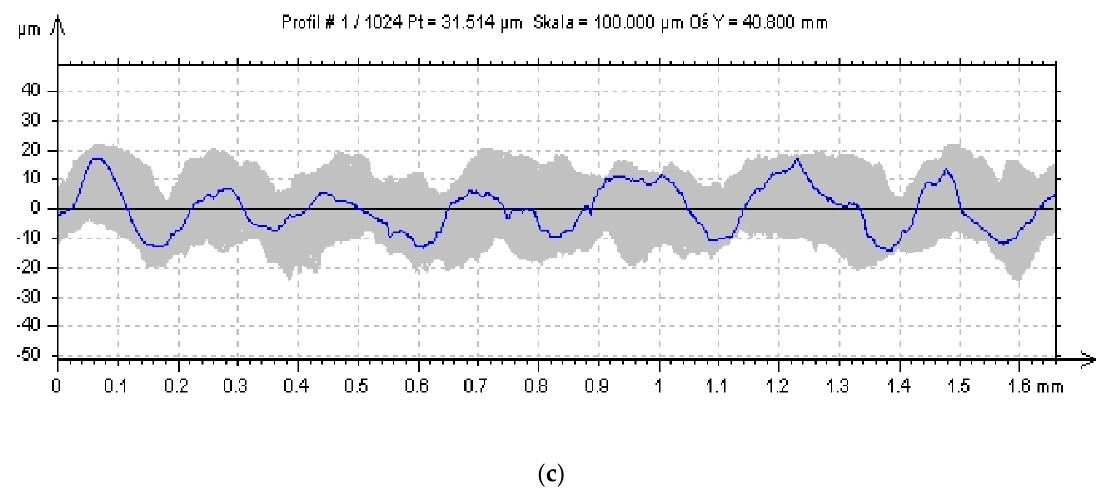
Figure 8. 2D roughness profile for samples: ( a ) 0°, ( b ) 45°, and ( c ) 90°.